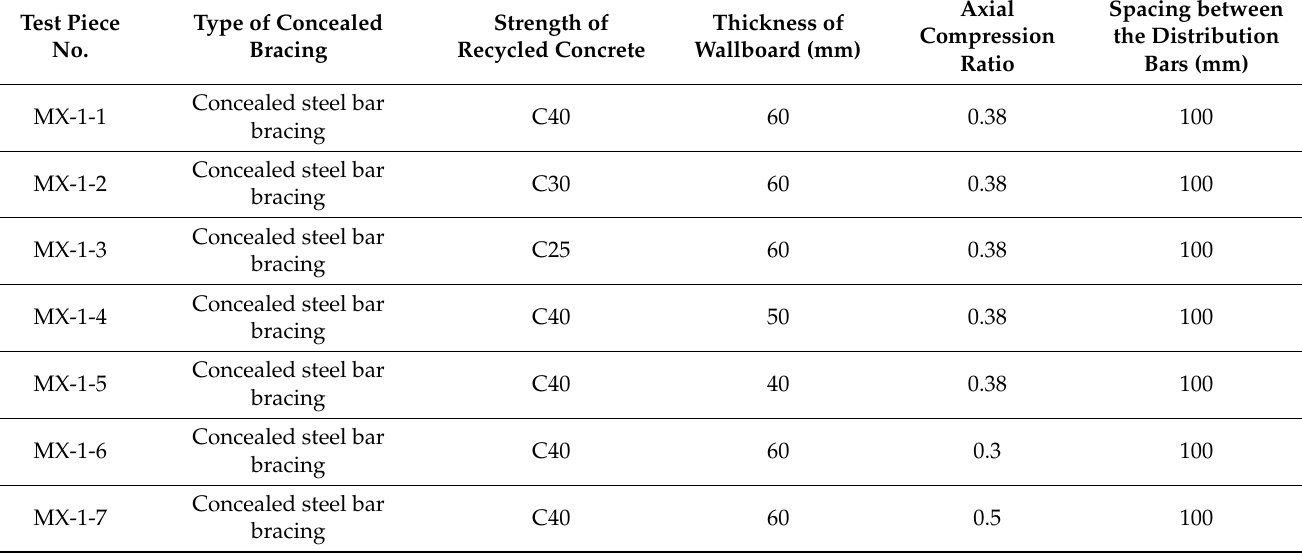
Table 4. Parameters of the virtual test